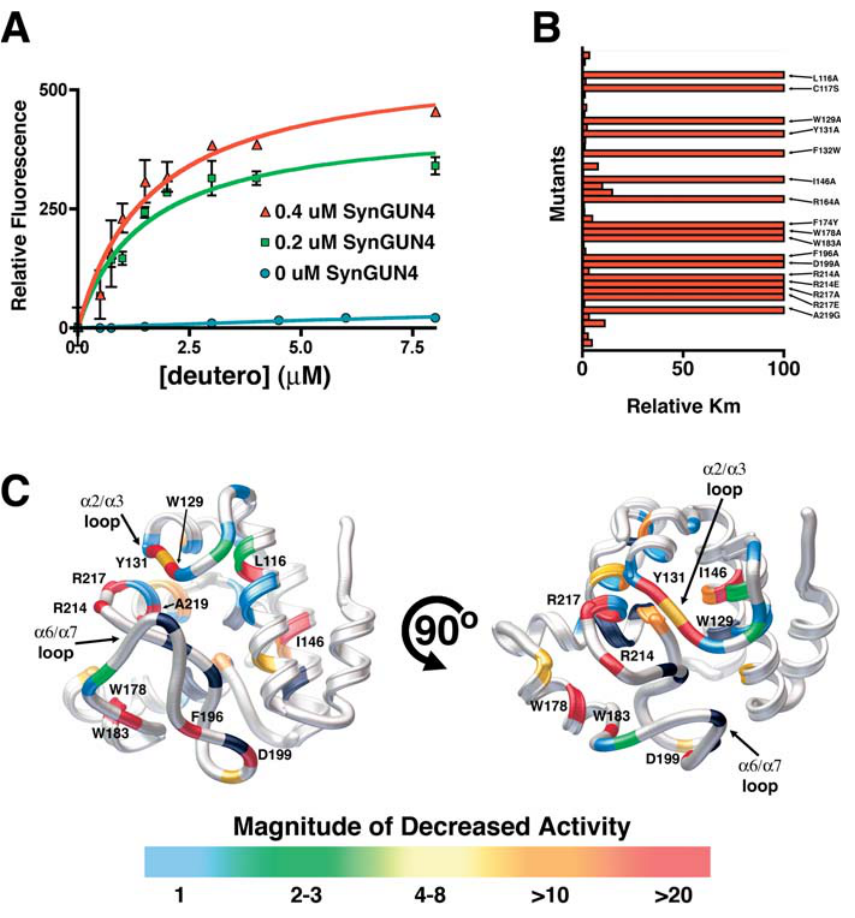
Figure 7. Quantitative Analysis of the GUN4 Stimulation of Mg 2 þ Incorporation into Deutero (A) The K m values for GUN4 assisted Mg-Deutero biosynthesis were determined using both 0.2 l m (red) and 0.4 l M SynGUN4 (green). The resultant values contrast with those obtained for Mg 2 þ incorporation by the Mg-chelatase complex in the absence of SynGUN4 (blue). (B) Relative K m values (compared to wild-type SynGUN4) were determined for each SynGun4 mutant previously examined for Deutero binding. (C) Rendered ribbon diagrams of orthogonal views of the SynGUN4 core domain with the relative K m values of each SynGUN4 mutant mapped onto the structure. The color-coded scale for each mutation’s effect on Mg 2 þ incorporation is shown at the bottom. Several mutants that altered Mg 2 þ incorporation activity but previously did not affect binding to deuteroporphyrin IX were uncovered including a R217A mutation and the Trp129 and Tyr131 residing on the a 2/ a 3 loop. Mutants of Val218, the later of which is critical for binding Deutero but not for binding Mg- Deutero showed no effect on chelatase activity while mutants of Ala219, the later of which is essential for binding to Mg-Deutero, completely failed to stimulate Mg-chelatase activity. Only those mutant SynGUN4s exhibiting a greater than 10-fold change in K m are labeled. Shown in black are residues that, when mutated to alanine, failed to produce properly folded protein upon expression in E. coli . DOI: